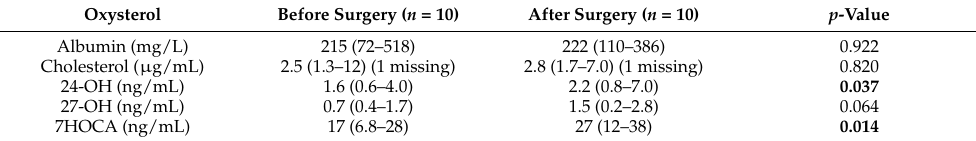
Data is presented as median (range). Data compared using the Wilcoxon signed-ranks test (matched continuous data). Bold text in the p -value column indicates a statistically significant association ( p < 0.05).